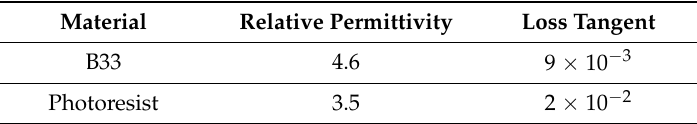
Table 4. Dielectric parameters of sensor